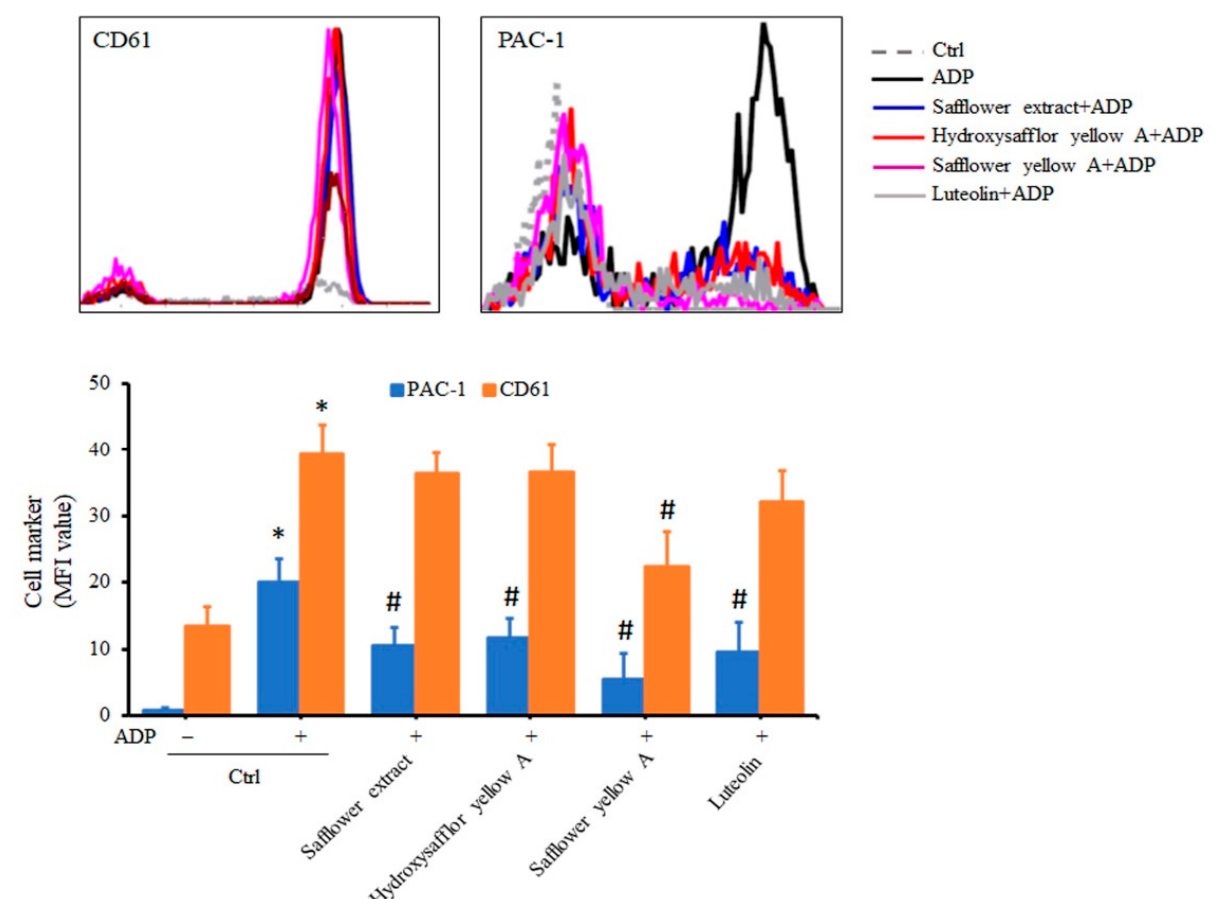
Figure 6. Effects of safflower extract on the surface activation markers of human platelets. Diluted whole blood was treated with safflower extract or compounds found in safflower extract for 1 h, stained with fluorescent antibody, and stimulated with ADP. After platelet fixation, the content of activation markers on the platelet membrane was analyzed by flow cytometry. * p < 0.05 when compared to the control group. # p < 0.05 when compared to the ADP treatment group.